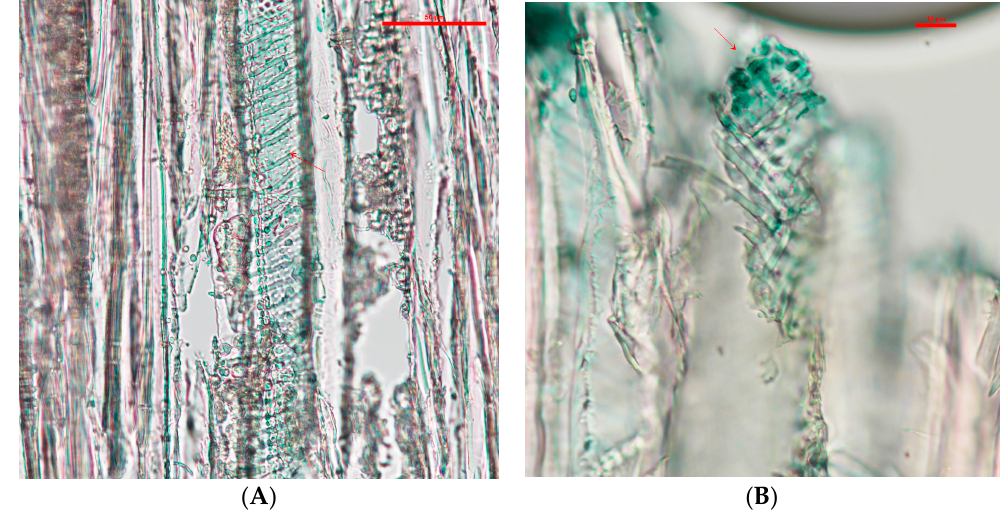
Figure 2. ( A ) Vessel cell wall of cottonwood covered with extracted pigment, pointed to with arrows, from C. aeruginosa taken at a 20× magnification; ( B ) Detail of the vessel cell wall showing concentration of the pigment in the vessel pits at a 40× magnification. Picture taken with a Nikon Eclipse Ni-U.